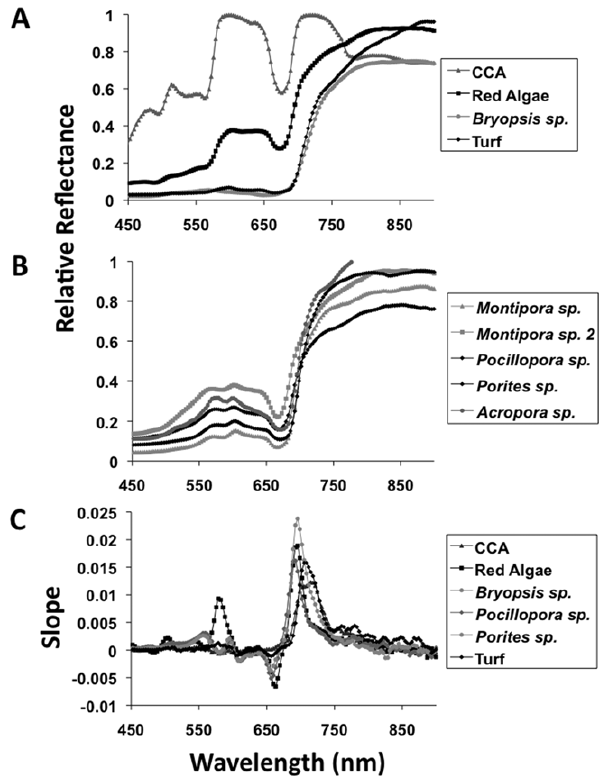
Figure 3. Comparison of spectra from different algal and coral groups. A) Relative reflectance of different algae: CCA, red alga, Bryopsis sp., and turf algae. B) Relative reflectance of 4 different corals: Montipora sp. (2), Pocillopora sp., Porites sp., and Acropora sp. C) Slope of coral and algal reflectance spectra, including CCA, red alga, Bryopsis sp., Pocillopora sp., Porites sp., and turf algae.